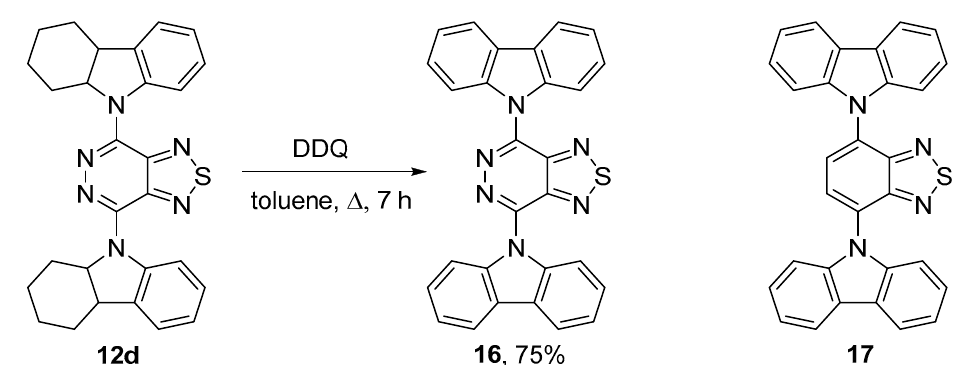
Scheme 4. Synthetic route to 4,7-di(9 H -carbazol-9-yl)[1,2,5]thiadiazolo[3,4- d ]pyridazine ( 16